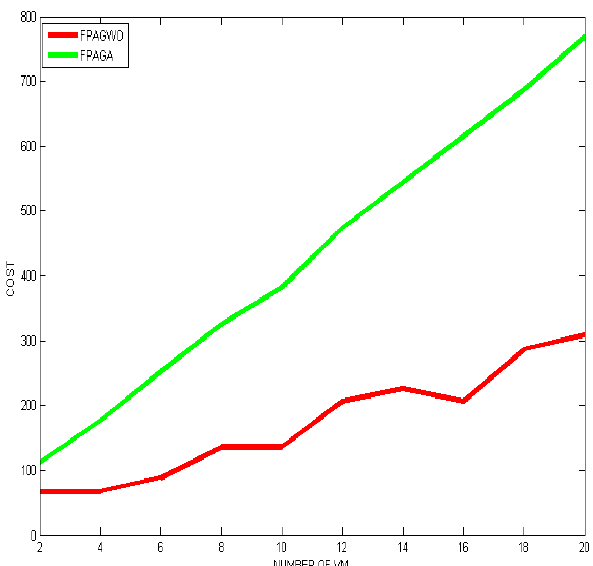
Figure 6. Cost on Genome workflow for FPA_GWO and FPA_GA